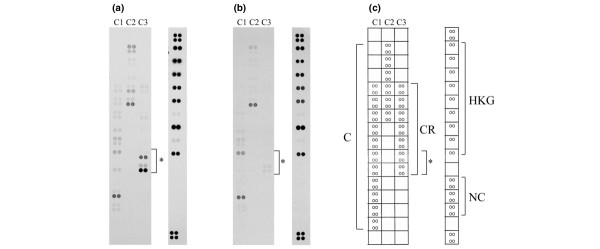
Microarray analysis of chemokine and chemokine receptor expression in the rheumatoid arthritis (RA) and non-RA synovia. A pair of human cytokine array membranes were hybridized to 33P-labelled cDNA probes prepared from pools of (a) RA mRNA (n = 8) and (b) non-RA mRNA (n = 9). The membranes were washed and autoradiographed. (c) The position of the 33 chemokines (C), the 16 chemokine receptors (CR), the nine positive control 'housekeeping genes' (HKG) and the six negative controls (NC). Each gene was printed in duplicate. The star indicates the position of the genes CXCR1, CXCR2, CXCR4 and CXCR5 (reading top to bottom) and shows their differential expression in RA and non-RA synovia. Exposure time was 7 days and 14 days for (a) and (b), respectively.